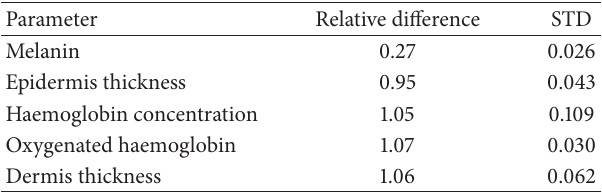
Table 7: Average difference between vitiligo and healthy